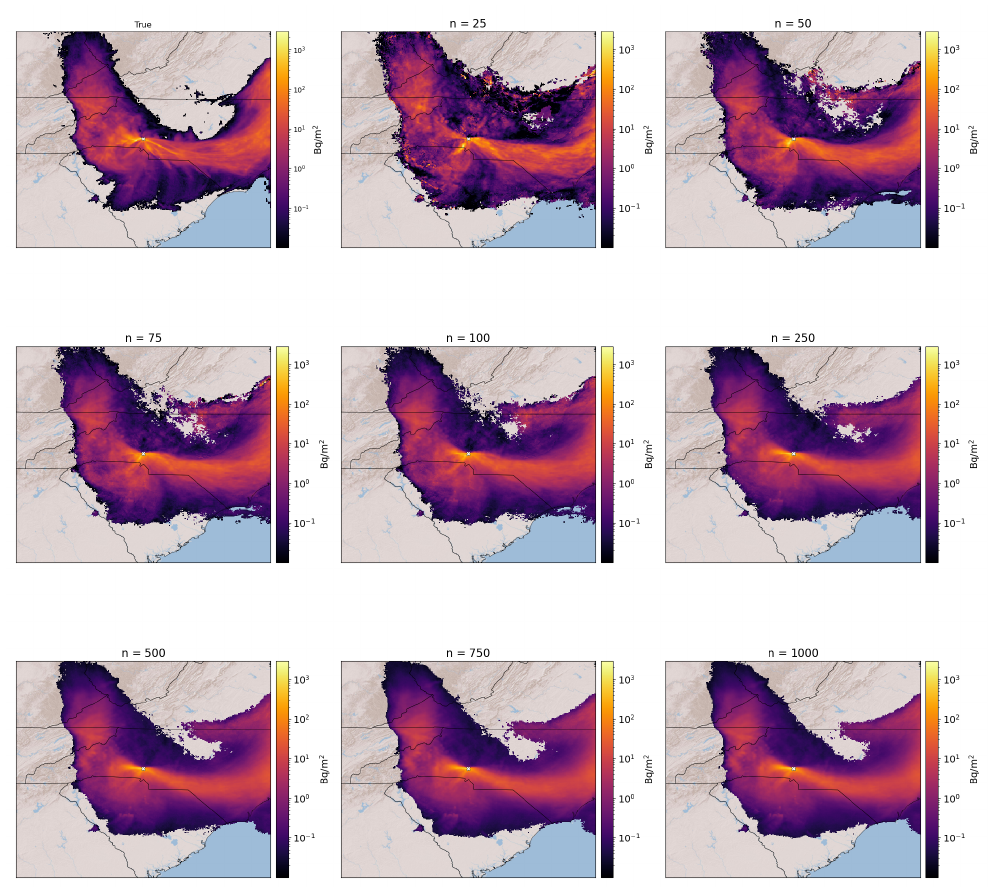
Figure 7. Spatial prediction for ensemble member 296 as the training set size increases. The true FLEXPART-WRF output is the top left subplot. The samples in the training set are randomly selected and the p threshold value is 0.5. Ensemble member 296 was in the test set for all training sizes. The WRF parameterization choices for this ensemble member were PBL 2, LSM 1, CU 5, MP 4, and RA